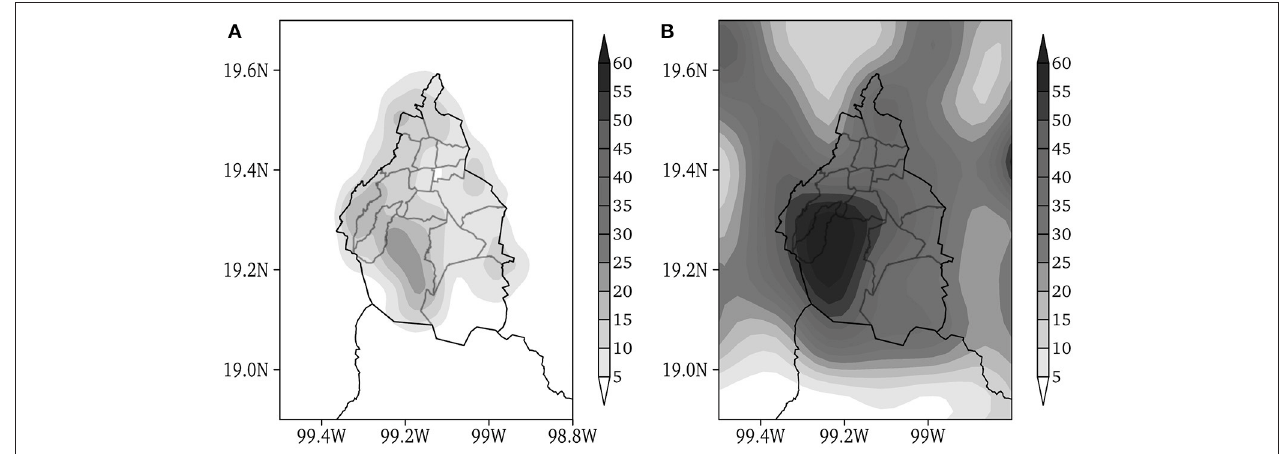
FIGURE 13 | Accumulated precipitation between 12:00 UTC 16 July and 12:00 UTC 17 July 2014: (A) Observed (mm); (B) WRF predicted.